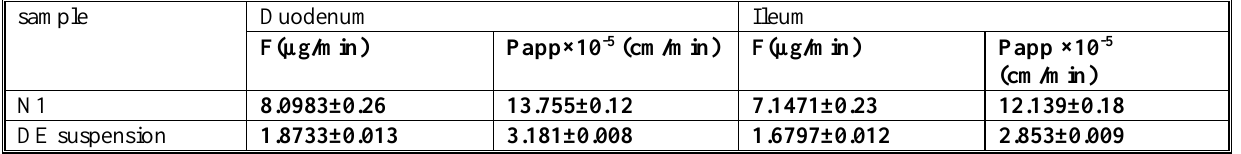
Table 6. The ex-vivo absorption parameters of dabigatran etexilate from optimized formula N1 and pure drug suspension, results were presented as mean ±SD (n=3)